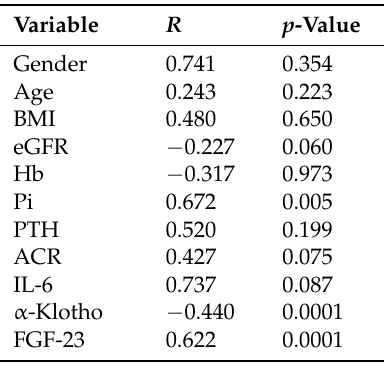
Table 3. Simple linear regression analysis between LVMI and other